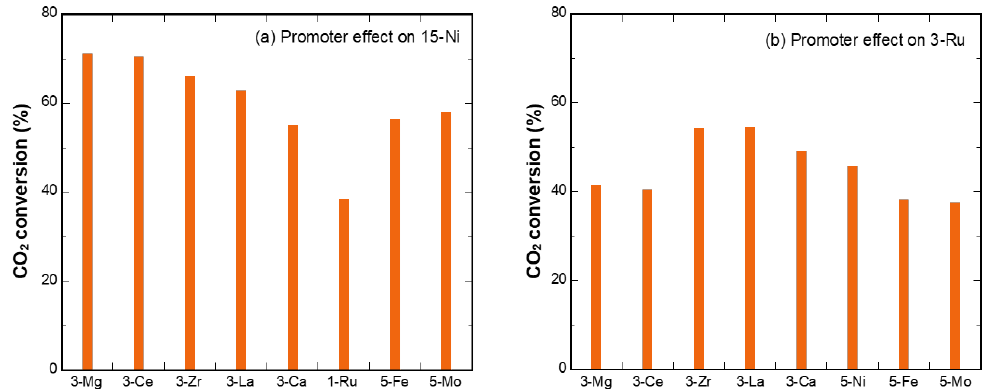
Figure 2. CO 2 methanation activity of ( a ) promoter-doped Ni/Eco and ( b ) promoter-doped Ru/Eco (400 °C, GHSV = 16,000 /h, 4% H 2 and 1% CO 2 ) .